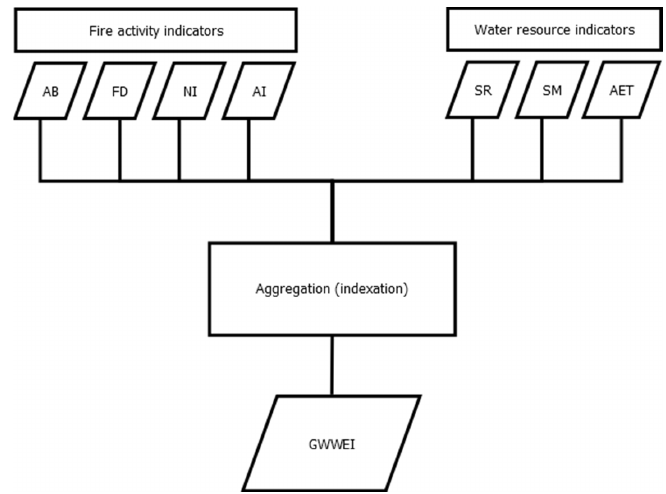
Figure 1. Schematic of the global wildfire water exposure index (GWWEI) framework. AB, area burned; FD, fire danger; NI, natural ignitions; AI, anthropogenic influence; SR, surface runoff; SM, soil moisture; AET, actual evapotranspiration. Table 1. Summary of datasets used to develop the GWWEI indicators. NASA: National Aeronautic and Space Administration, SEDAC: Socioeconomic Data and Applications Center, GWSP: Global